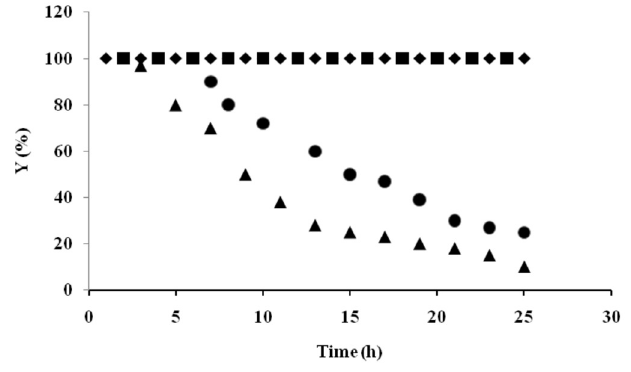
FIGURE 1 - Variation in conversion during continuous sucrose hydrolysis catalyzed by soluble invertase [test 1 (  )] and immobilized invertase [test 3 (  ); test 4 (  ) and test 8 (  )]. In all tests, the protein loading was equal to 1.64 mg/mL.